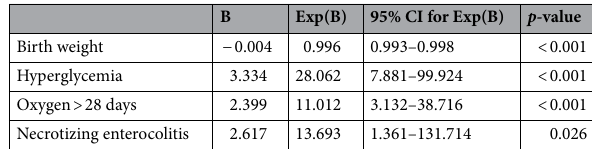
Table 5. Risk factors for ROP after multivariate regression